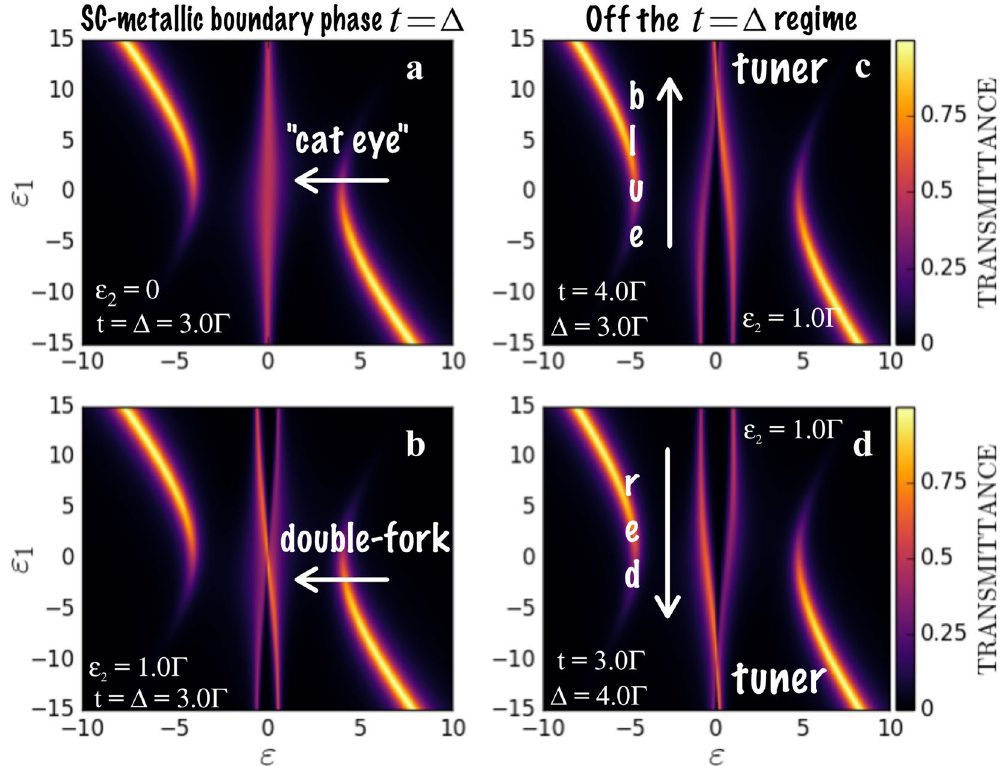
Figure 4. Transmittance  spanned by the axes of ε 1 and ε . Panels (a,b) show the regime corresponding to SC- metallic boundary phase with t = Δ , for ε 2 = 0 and finite ε 2 , respectively. Panel (a) reveals characteristic “cat eye”-shaped central structure at the Fermi level responsible for the onset of the conductance plateau. Panel (b) exhibits a double-fork structure responsible for the resonant character of the conductance for ε 2 ≠ 0. Introduction of the asymmetry of the QD to MFs coupling leads to the vertical shift of the double-fork feature resulting in the blueshift (panel (c)) or redshift (panel (d)) of the resonant conductance curve. The bright arcs visualized in all panels represent poles of the Green’s function of the QD.